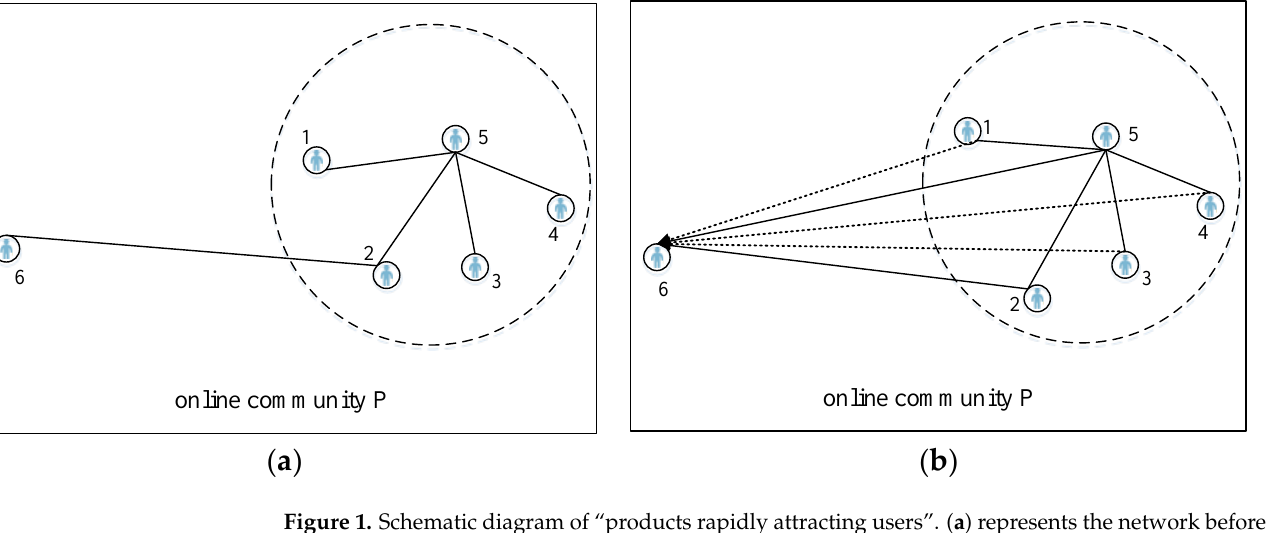
Figure 1. Schematic diagram of “products rapidly attracting users”. ( a ) represents the network before evolution, the users that belong to online community P are 1, 2, 3, 4, and 5, ( b ) shows the network after evolution.